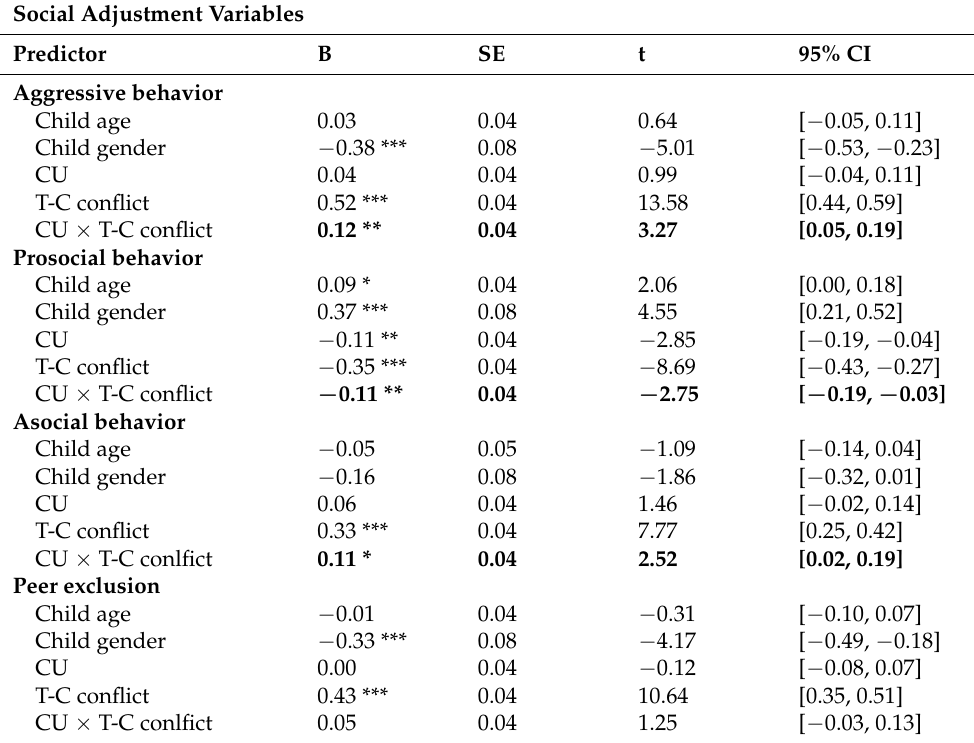
Table 2. Effects of CU traits, teacher-child conflict in relation to indices of social adjustment. Social Adjustment